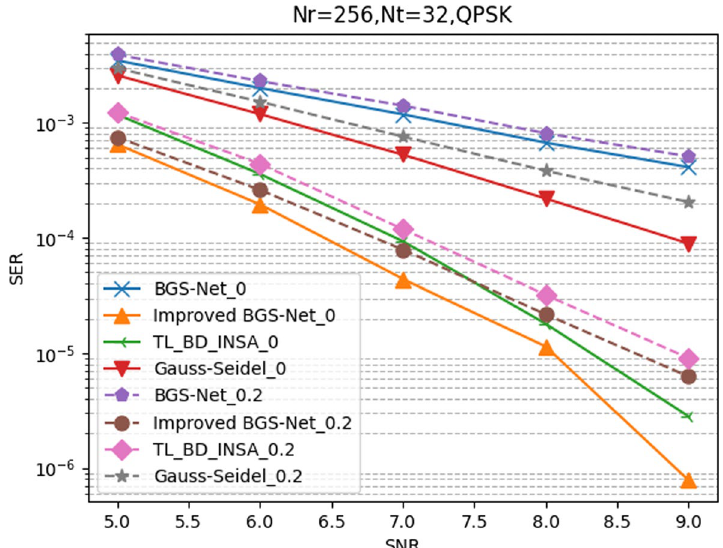
Fig. 27 SER performance comparison of different algorithms for N t = 32,N r = 256 , QPSK, MAUE system with ξ r = 0 or 0.2, ξ t = 0.4